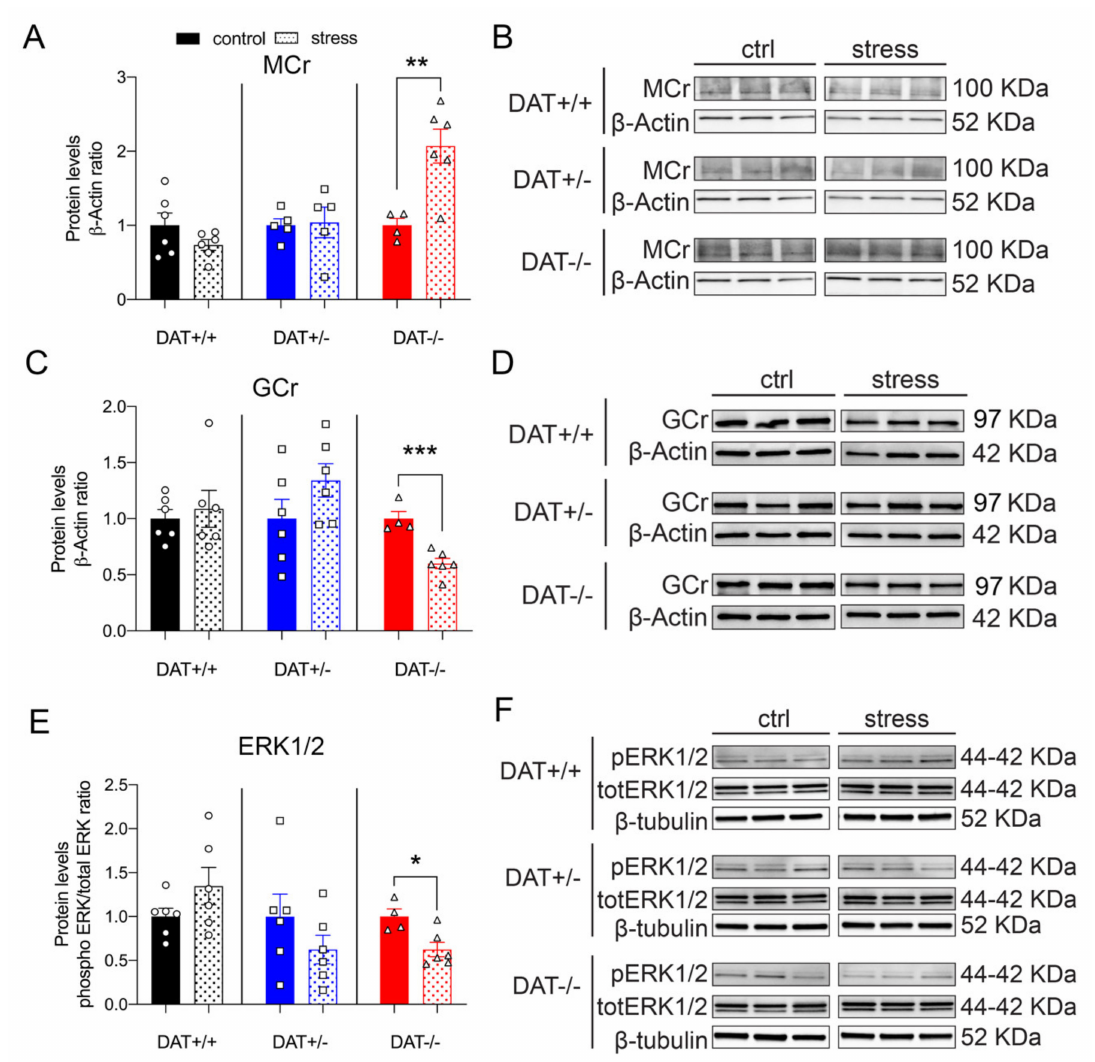
Figure 8. Restraint stress e ff ects on steroid hormones and dopamine D2 receptor signaling in the hypophysis of female DAT-KO rats. ( A ) Exposure to restraint stress significantly increased MCr in DAT- / - rats. ( C ) GCr protein levels were significantly reduced after stress in DAT- / -. ( E ) The e ff ects of restraint stress on ERK1 / 2 protein levels were significantly reduced only in DAT- / - rats. ( B , D , F ) Immunoblots from representative rats in each group are shown. Data were normalized to β -actin or β -tubulin. For each genotype, data were expressed as relative to basal (non-stress) conditions. Data are expressed as mean ± SEM ( n = 4–6), * p < 0.05, ** p < 0.01, *** p <